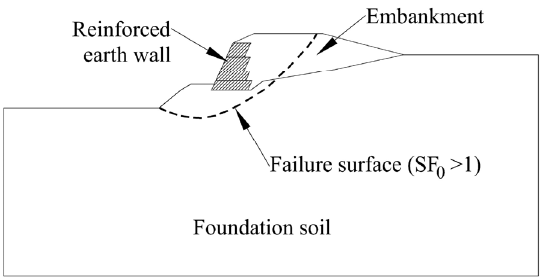
Figure 11. Significant scenario representing the failure mechanism and the stability condition (safety factor SF 0 > 1) of the embankment in the case of homogeneous foundation soil. The failure mechanism has been drawn on the basis of the numerical results, in particular of the concentration of the shear strain in the phi-c reduction phase.